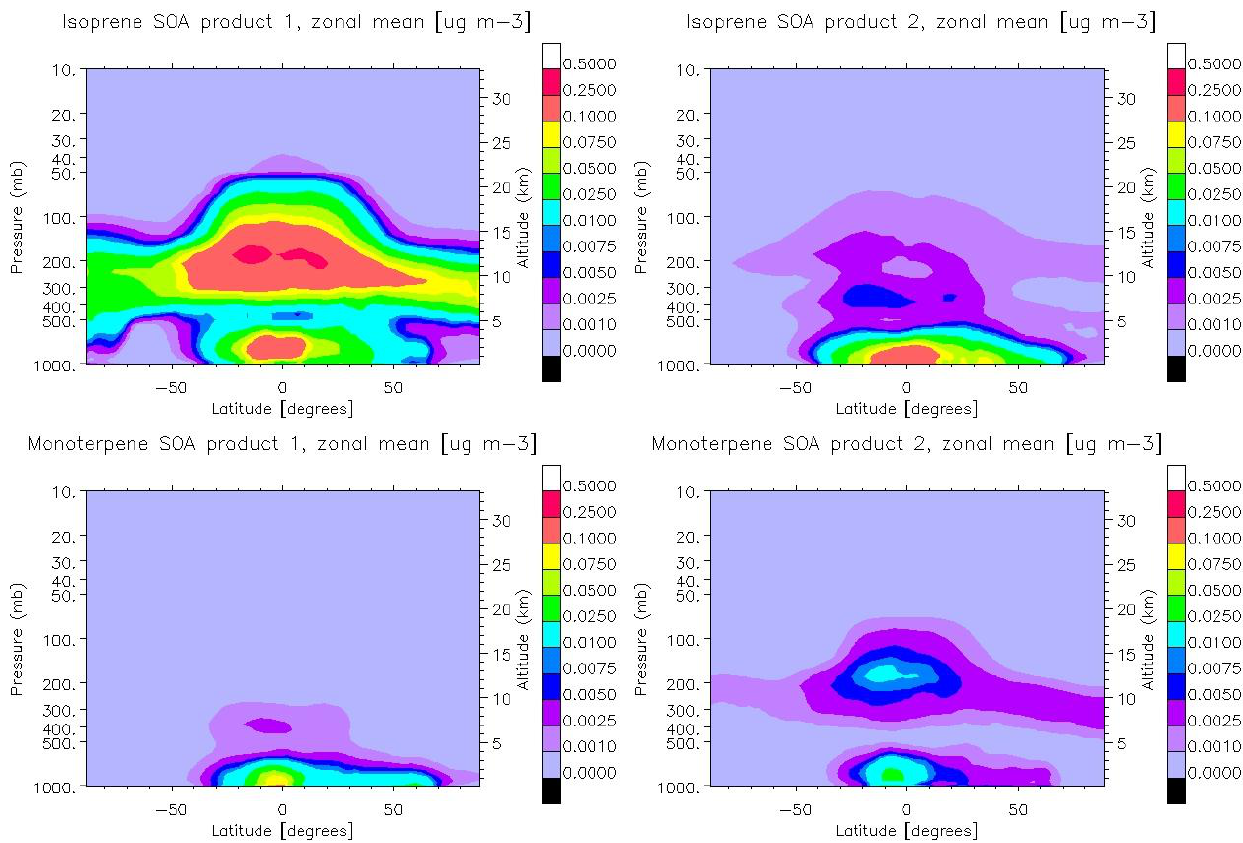
Fig. 6. Vertical profile of aerosol phase mass of each model semi-volatile species